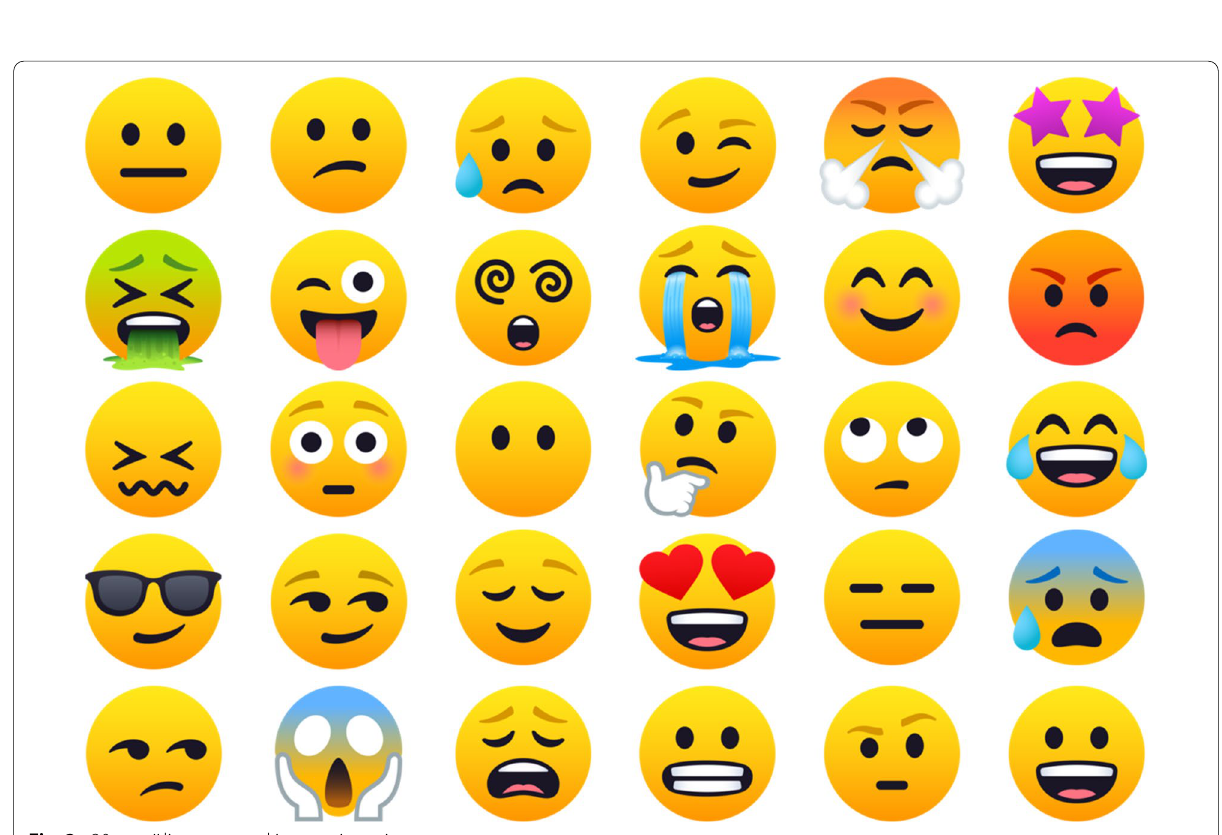
Fig. 2. 30‑ emoji list presented in